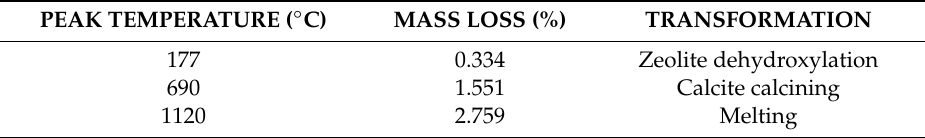
Table 11. Transformation temperature from TG-DSC of combustion chamber thermal analysis.